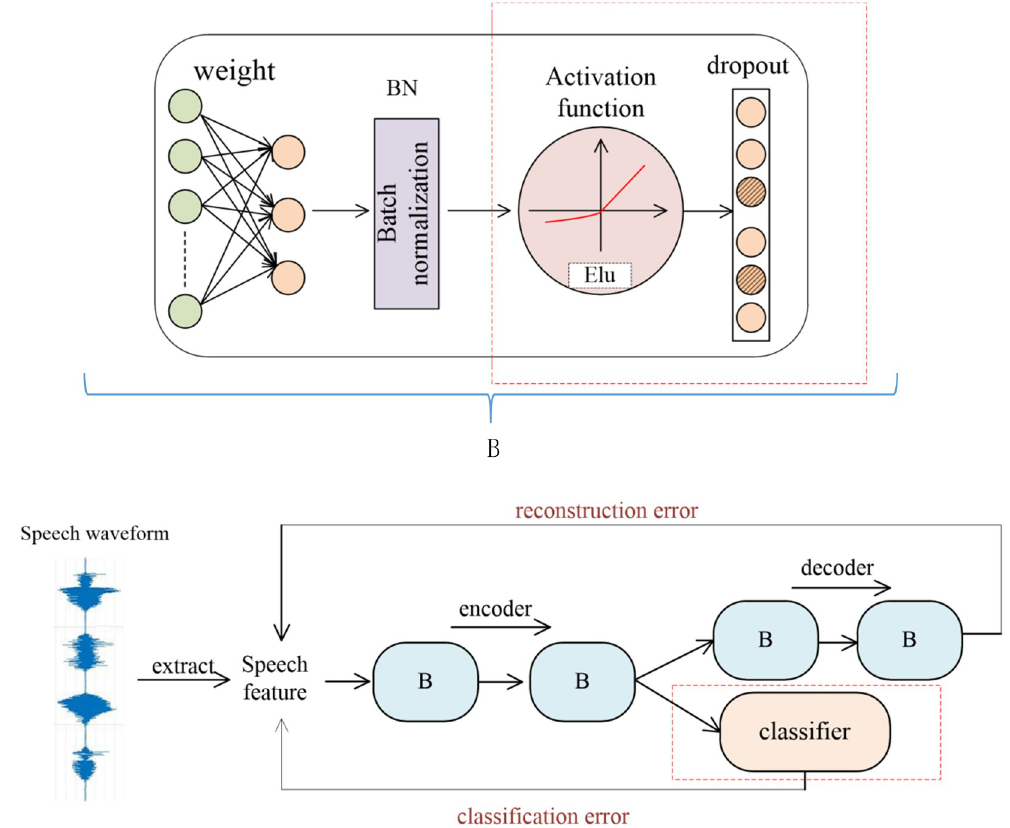
Fig 2. Structure of semi-supervised additive noise